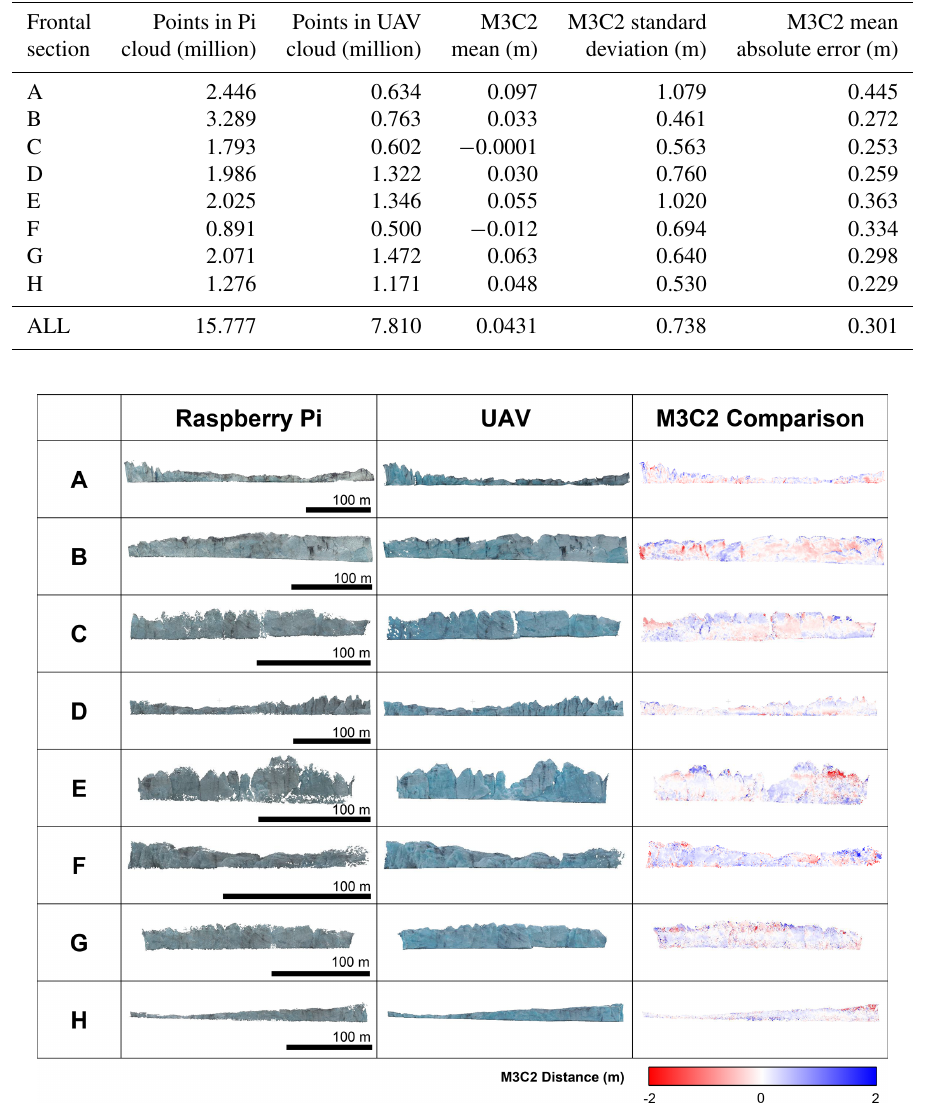
Table 2. Key statistics and M3C2 comparison between point clouds generated by the Raspberry Pi and UAV. Frontal sub-sections can be seen in Fig. 1.